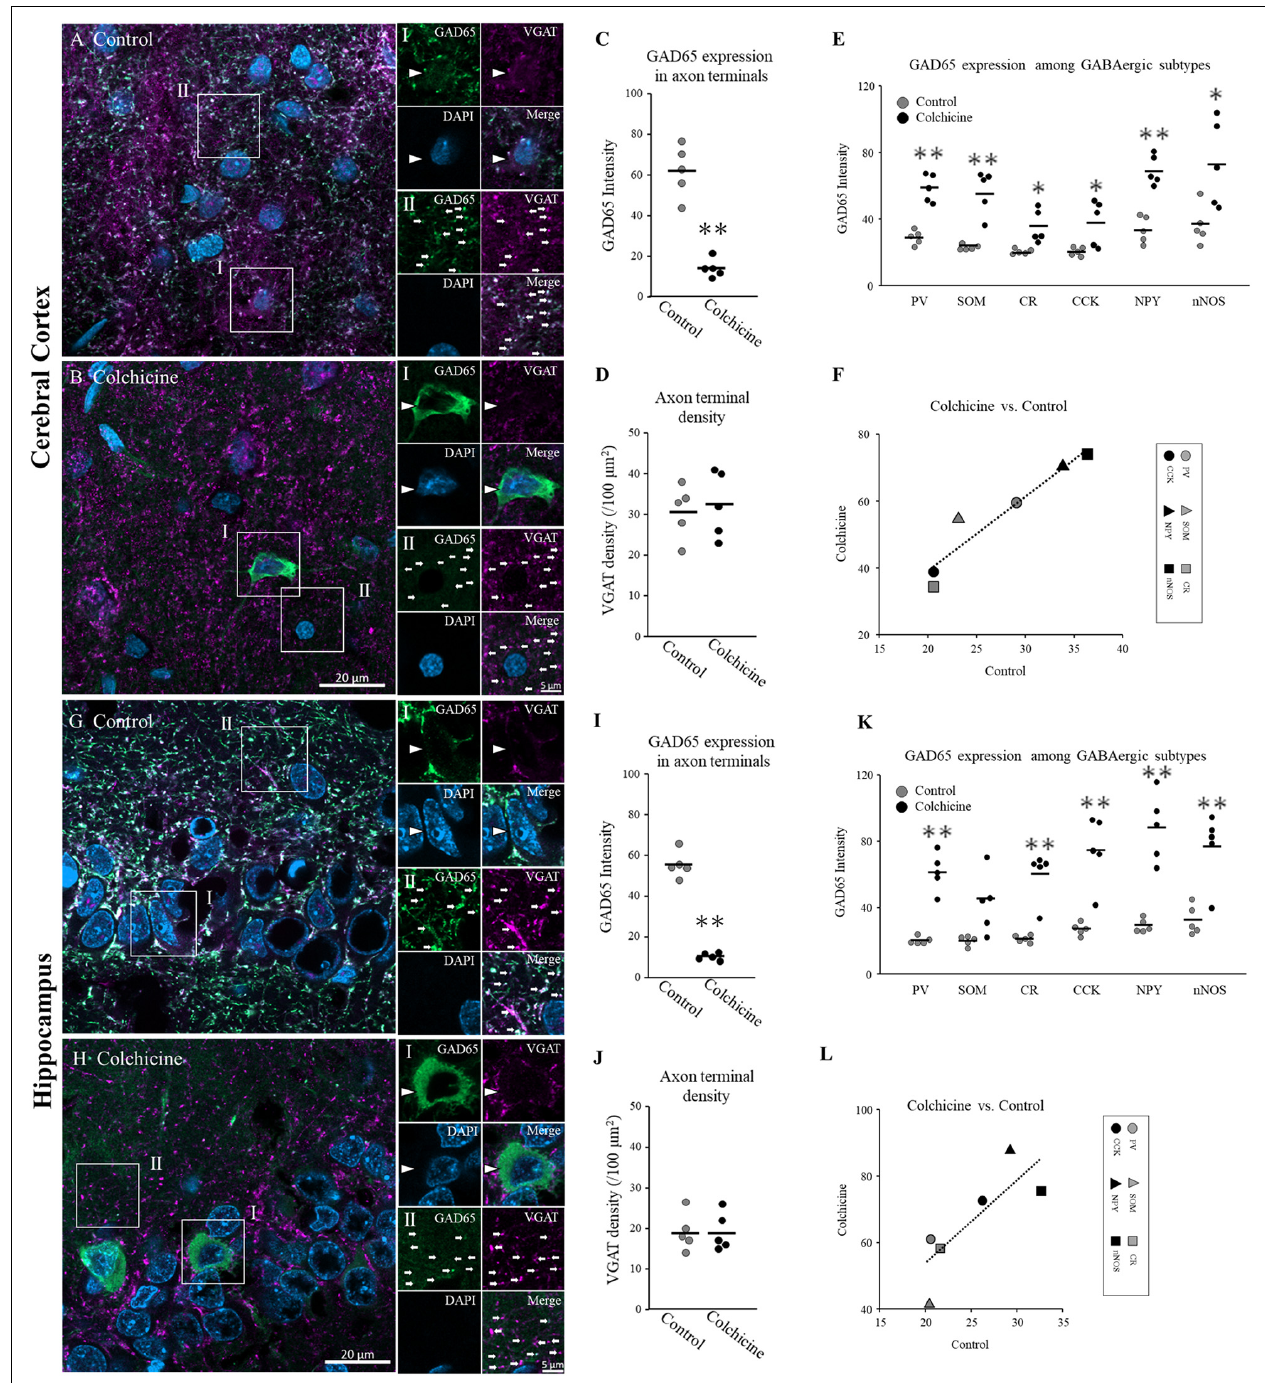
FIGURE 6 | GAD65 expression in the cerebral cortex and hippocampus of colchicine-treated rats ( n = 5 brains). Triple immunofluorescence image showing GAD65 (green), VGAT (magenta), and DAPI (blue) signals (cerebral cortex: A,B ; hippocampus: G,H ). White squares (I: soma; II: neuropil) indicate the regions enlarged in the panels on the right, and arrowheads and arrows indicate somata and axon terminals, respectively. The average GAD65 immunostaining intensity in axon terminals (neuropil) in cerebral cortical layers (C) and hippocampal layers (I) . The density of VGAT immunostaining per unit area in cerebral cortical layers (D) and hippocampal layers (J) . The average GAD65 immunostaining intensity in soma in cerebral cortical layers (E) and hippocampal layers (K) among six GABAergic subtypes. Correlations in GAD65 staining intensities in six GABAergic subtypes in the cerebral cortex (F) and hippocampus (L) between the colchicine-injected group and the control group. Black bars indicate the mean value of five brains (C–E,I–K) . Error bars indicate SEM. Welch’s t -test revealed was used for (C,E,D,I,K,J) . Mann–Whitney U Test was used for (K) . Pearson’s correlation analysis was used for (F,L) . ∗ p < 0.05. ∗∗ p <